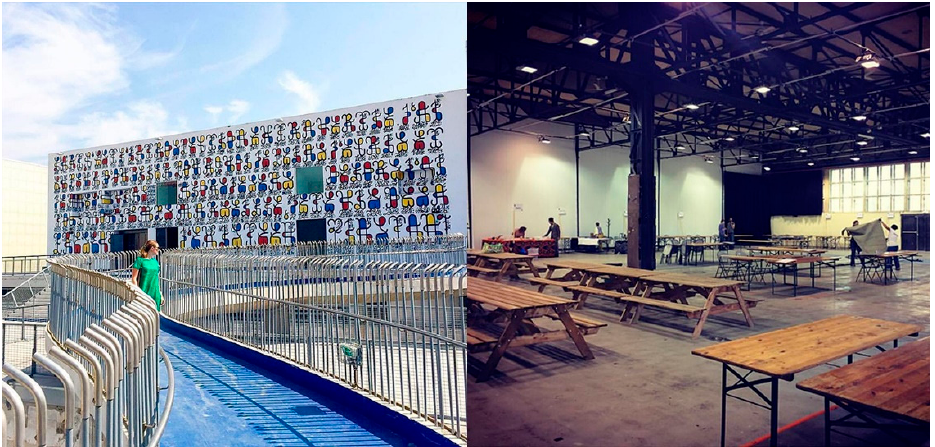
Figure 1. Two images from La friche instagram account. The first one is a repost from a follower. The second one is a promotional image for a coming soon